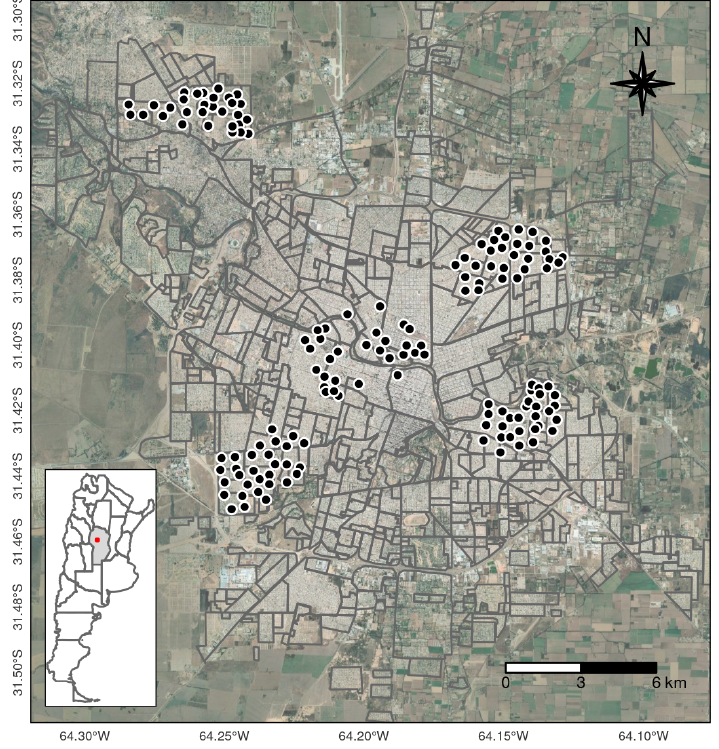
Figure 1. Distribution of ovitraps in Córdoba city